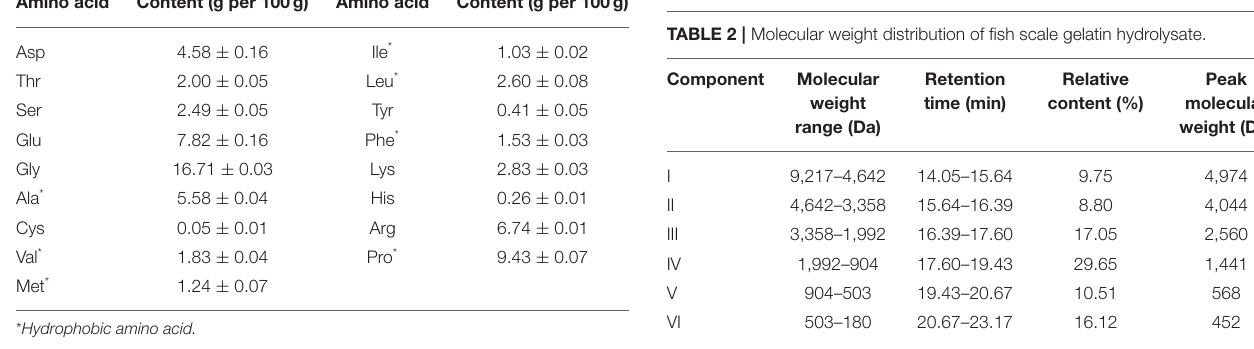
Frontiers in Nutrition |